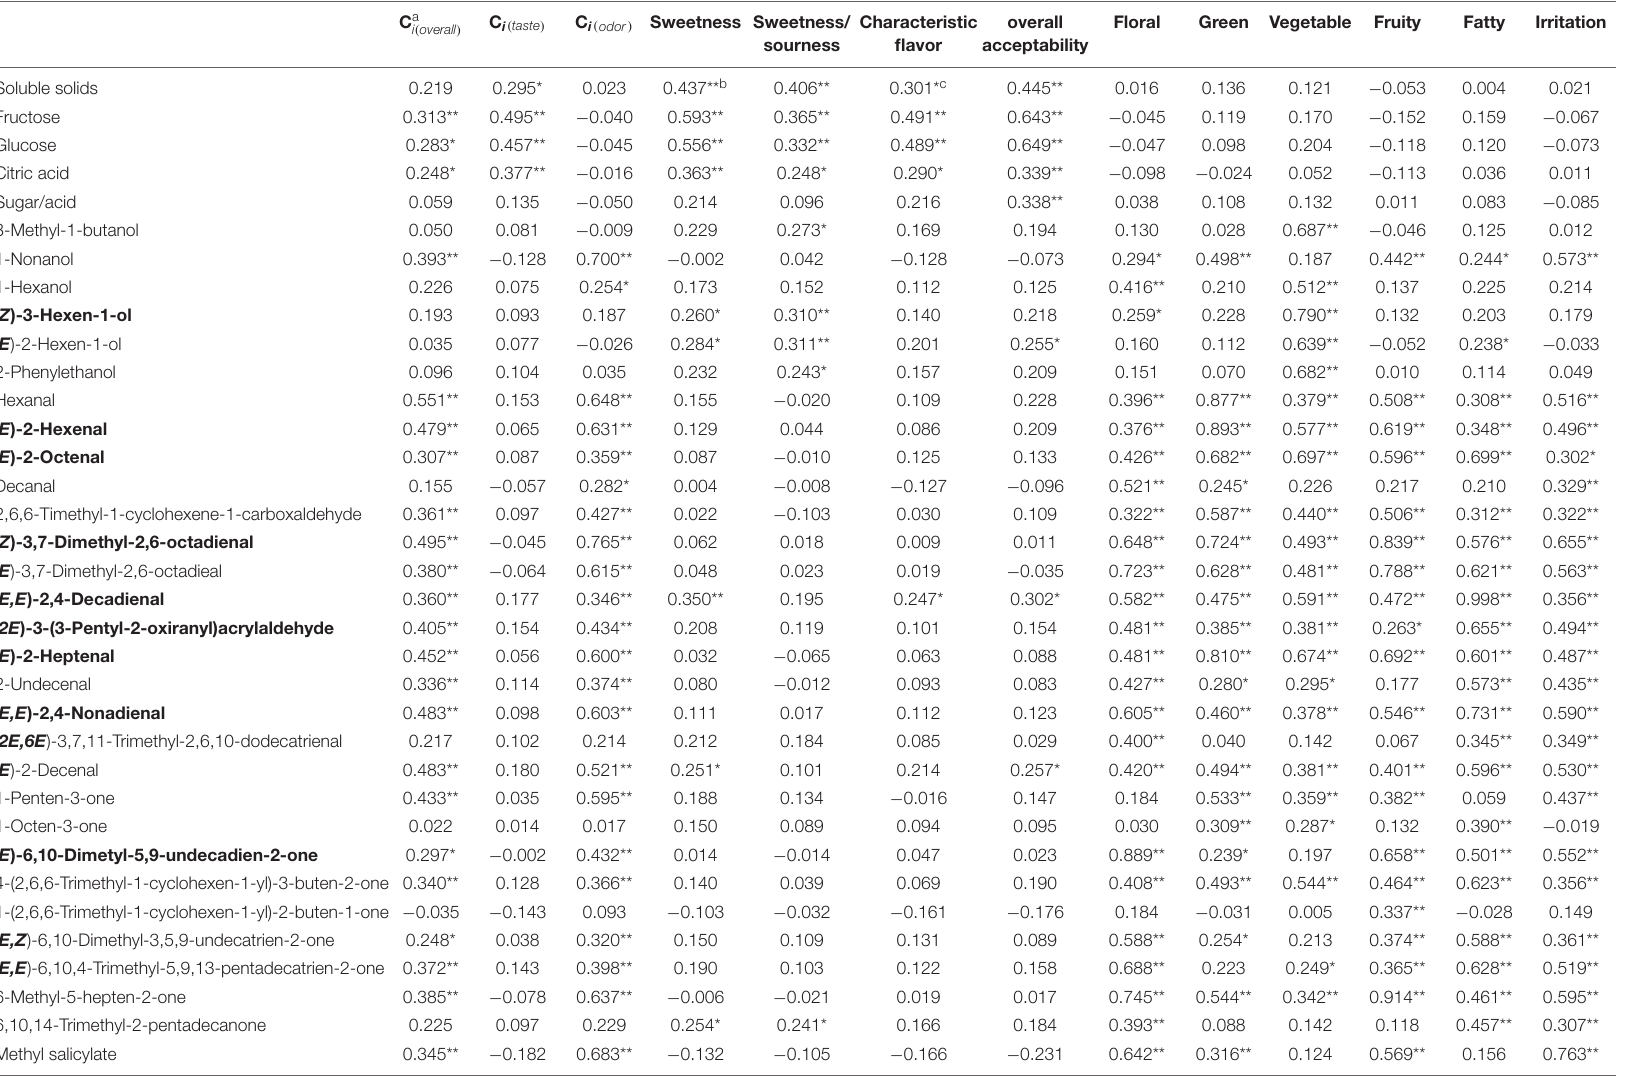
TABLE 4 | Correlations between flavor compounds and sensory evaluations in mature tomato